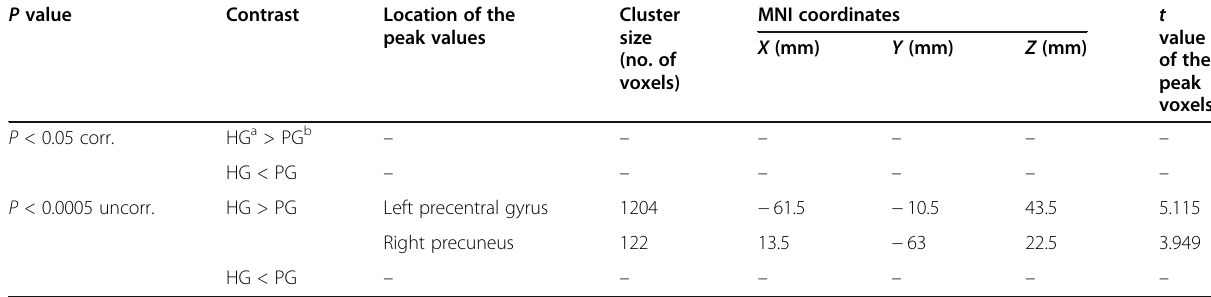
Table 2 GM alterations detected by